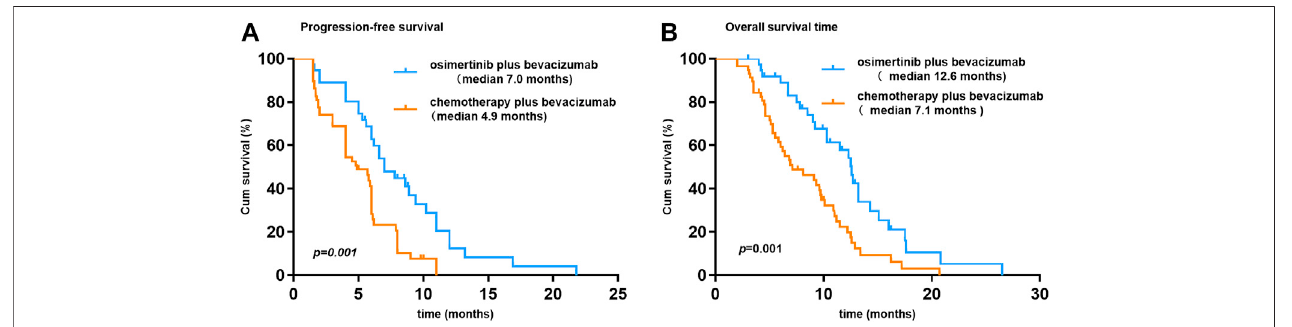
FIGURE 3 | Kaplan – Meier curves of progression-free survival and overall survival.